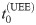
Price time series of a typical UEE to illustrate the definition of the recovery rate ηn.The shown excerpt is the price time series of AAPL on NASDAQ, 12/01/2008. The vertical lines mark the specific instances t0(UEE), t0(rec) and tn(rec) in time.